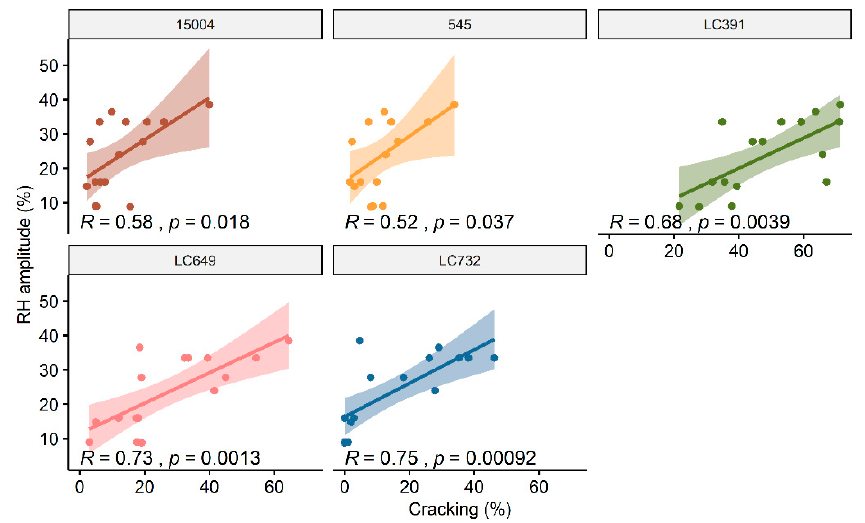
Figure 6. Environmental correlations (Pearson coefficient, R ; and significance of the correlation, p ) between cracking incidence and day–night amplitude for relative humidity recorded under open-air conditions. Each value represents the mean incidence in each harvesting day and for each trial (Exp: 7, 8, 9, 16).